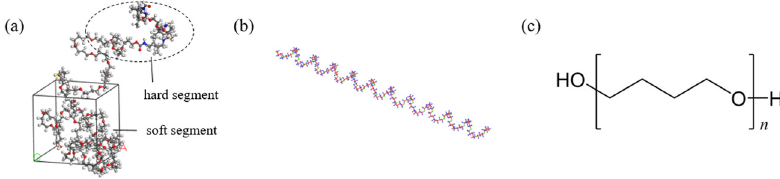
Figure 1: Material model of MD simulations: ( a ) microstructural composition of a fl exible polymer; ( b ) a typical molecular structure of soft segment with helical structure; and ( c ) molecular formula of the mono soft